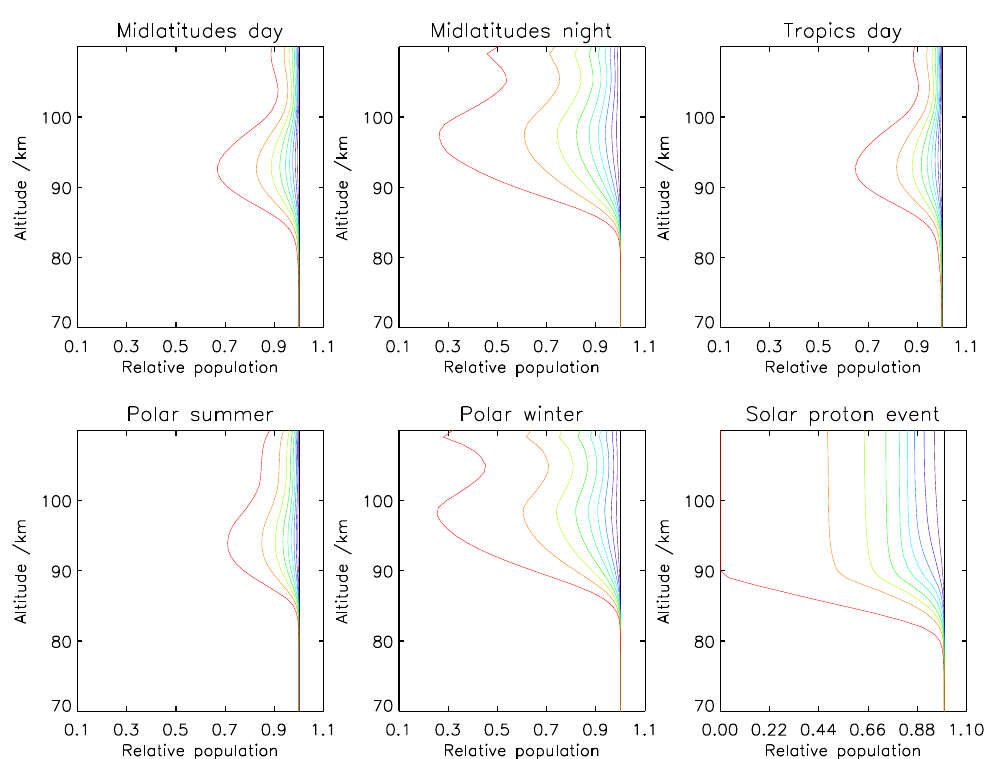
Fig. 1. Cumulative relative populations of the OH vibrational states as a function of altitude from groundstate (leftmost line) to total OH ( v = 0 ... 9) for various atmospheres. The distances between the lines represent the relative populations of of vibrational levels 1 to 9.